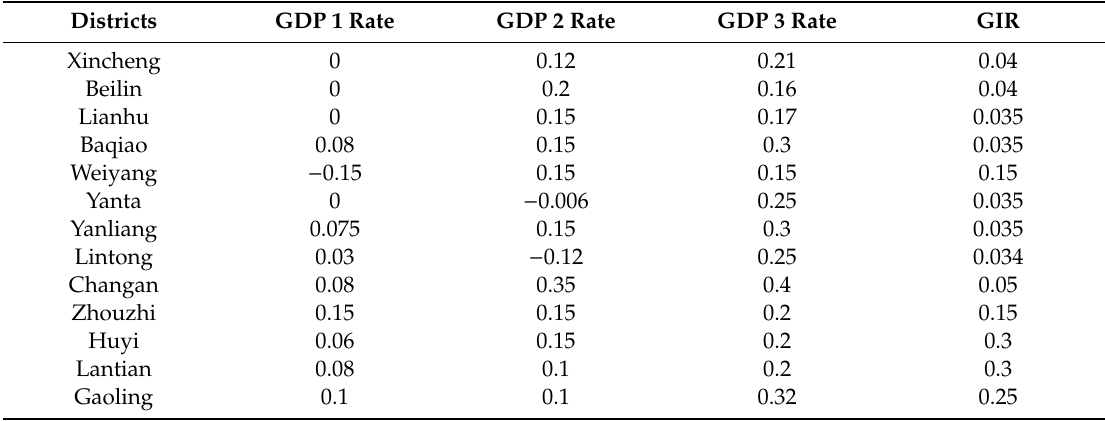
Table A5. Parameter setting of coordinated development